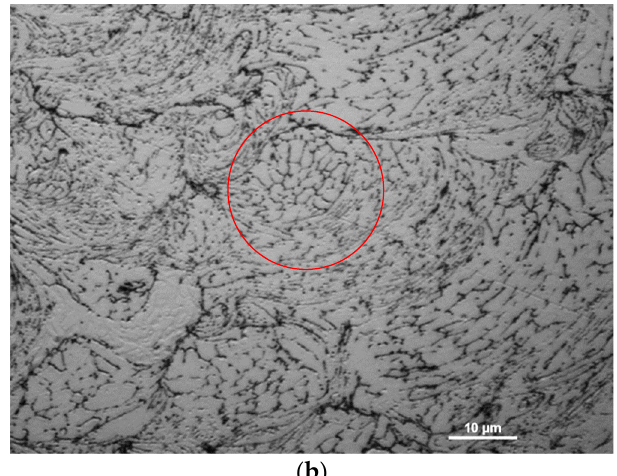
Figure 6. Optical cross-sectional micrograph for cold spray Al 6061, etched using Keller’s reagent, showing the particle morphologies after deposition. ( a ) There is some evidence of interparticle voids and porosity, as indicated by arrows and ( b ) high-magnification micrograph showing small average grain size and finer sub grains resulting from buildup of particles.